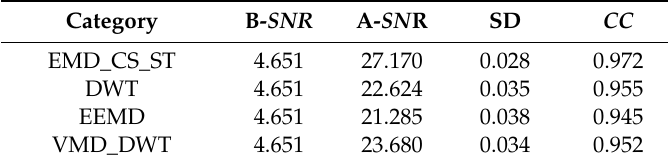
Table 1. Four methods for comparative analysis of the denoise e ff